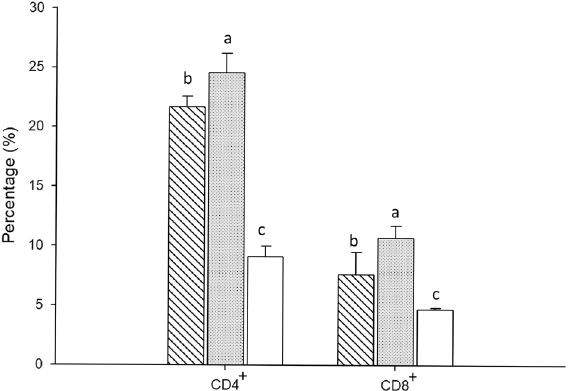
Figure 5. Flow cytometric analysis of the percentage of CD4 + and CD8 + T lymphocytes in spleen. Mice were immunized intraperitoneally twice at weeks 0 and 2 with truncated E2 glycoprotein, and mice in the control group were immunized with PBS. Mice splenocytes were isolated at 4 weeks post-immunized and stained with anti-mouse CD4 + and CD8 + monoclonal antibody. Data are presented as the mean ± standard deviations of the mice in the same treatment (n = 4). Different letters (a, b, c) on the bar indicate significant ( P < 0.05) between- group differences at the same time point.( ) Group I: 5 μg of truncated E2 glycoprotein;( ) Group II: 35 μg of truncated E2 glycoprotein;( ) Group III: